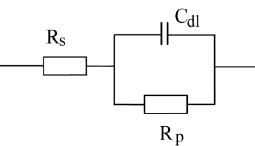
Figure 3. The two-time constant electrical equivalent circuits for porous coating [5,12,21].